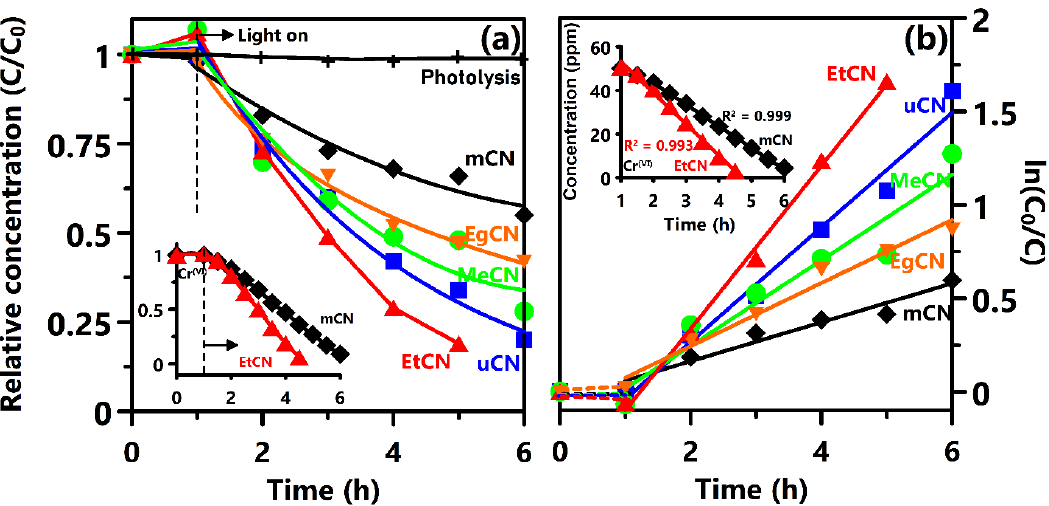
Figure 5. ( a ) Photocatalytic degradation of MO aqueous solution (2.5 × 10 −5 M) using mCN, uCN, MeCN, EtCN, and EgCN samples under irradiation from a Xe lamp, and ( b ) the pseudo-first-order reaction kinetics plot for these samples. Insets of ( a ) and ( b ) show the photocatalytic reduction of Cr (VI) using the mCN and EtCN samples, and their pseudo-zero-order reaction kinetics, respectively. Table 2. Reported reaction conditions, including light source, original concentration of MO or Cr (VI) solution, and photocatalytic performance using various polymeric g-C 3 N 4 samples. Samples